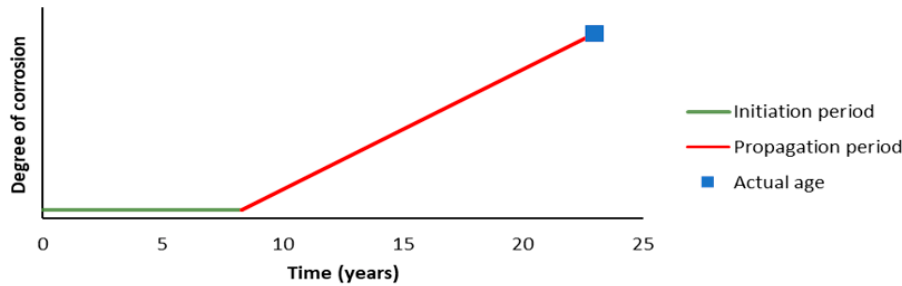
Figure 3. Qualitative representation of the service life of a structure affected by corrosion (degree of corrosion usually measured in loss of reinforcement section).